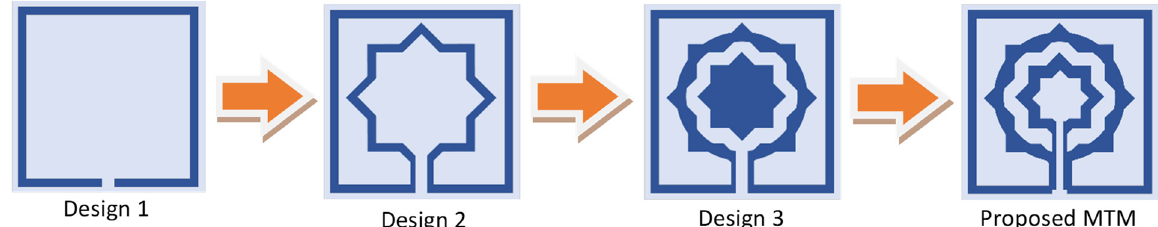
Figure 2. Evaluation steps toward the metamaterial design.